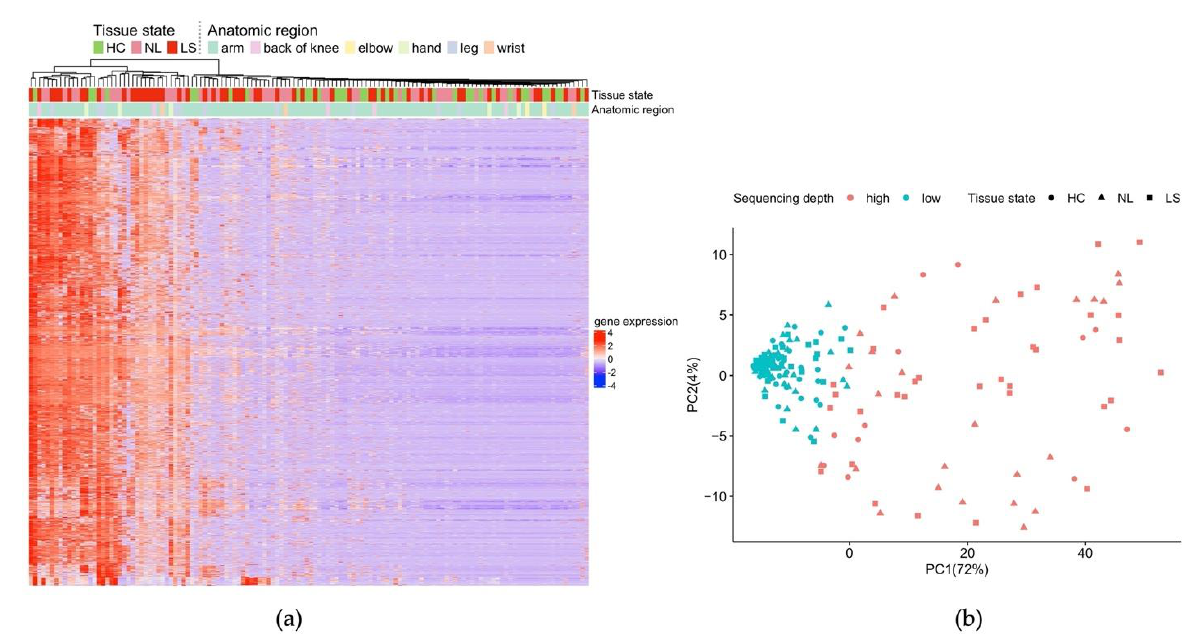
Figure 1. Overview of skin tape stripping BRB-seq data. ( a ) Heatmap and unsupervised hierarchical clustering based on 2310 expressed genes (rows) across 132 samples (columns). Counts are z-scaled. The anatomical region of sampling (arm: 106, leg: 11, hand: 5, back of knee: 5, wrist: 3, and elbow: 2) as well as tissue state are indicated above the plot; ( b ) corresponding sample PCA plot based on the same 2310 genes colored according to sequencing depth (high: counts ≥ 35,000).